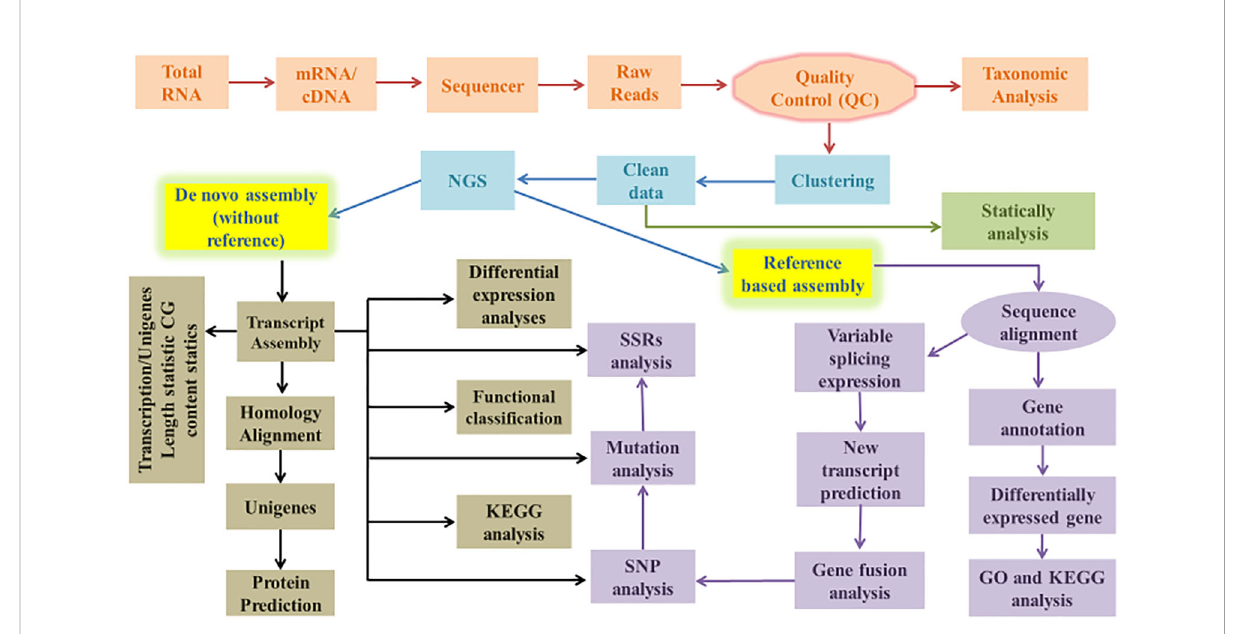
FIGURE 1 Flow chart of transcriptome ( De novo and reference based) data